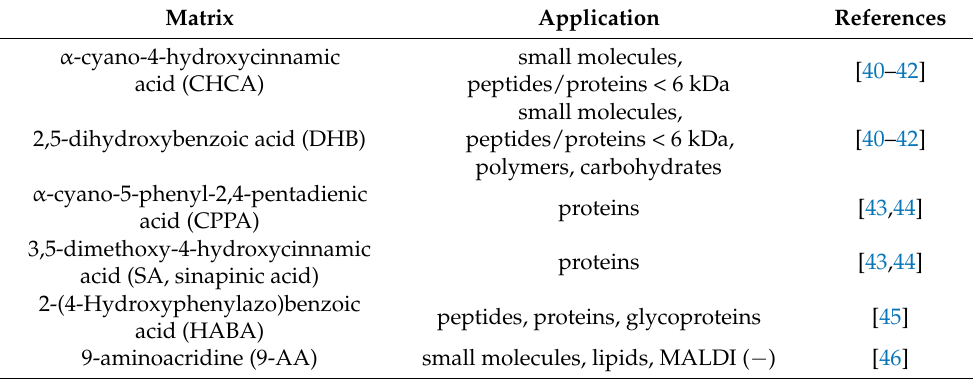
Table 1. Various Application of Organic Matrices in MALDI-MS.